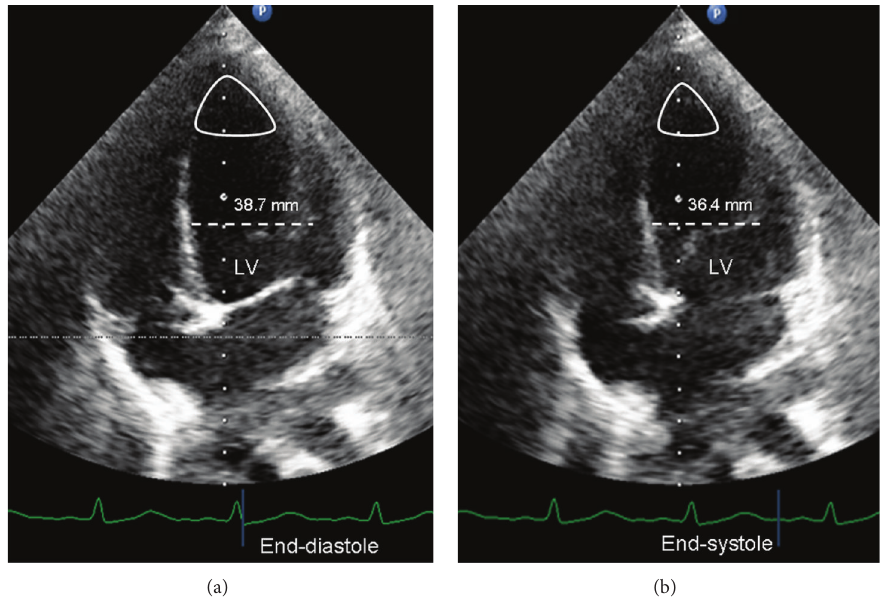
Figure 2: Transthoracic echocardiogram (4-chamber view) during end-diastole (a) and end-systole (b) shows basal and midventricular segmental hypokinesis (dotted line for reduced shortening) of the left ventricle (LV), with a well-preserved apical segmental systolic function